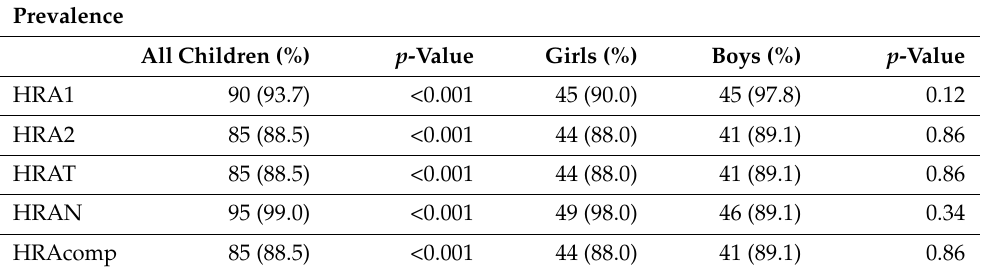
Table 2. Prevalence of different types of HRA in the whole group (n = 96) and compared